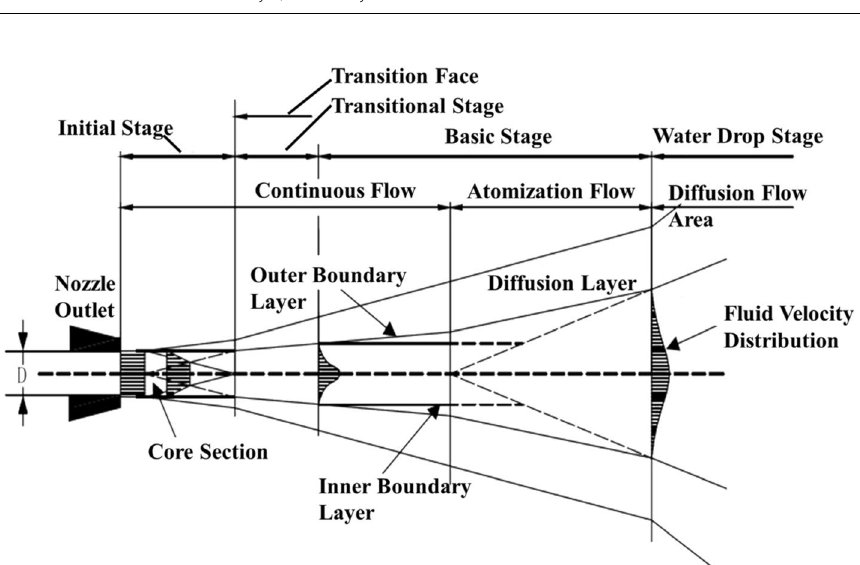
Fig. 2 Schematic diagram of the low pressure submerged jet structure